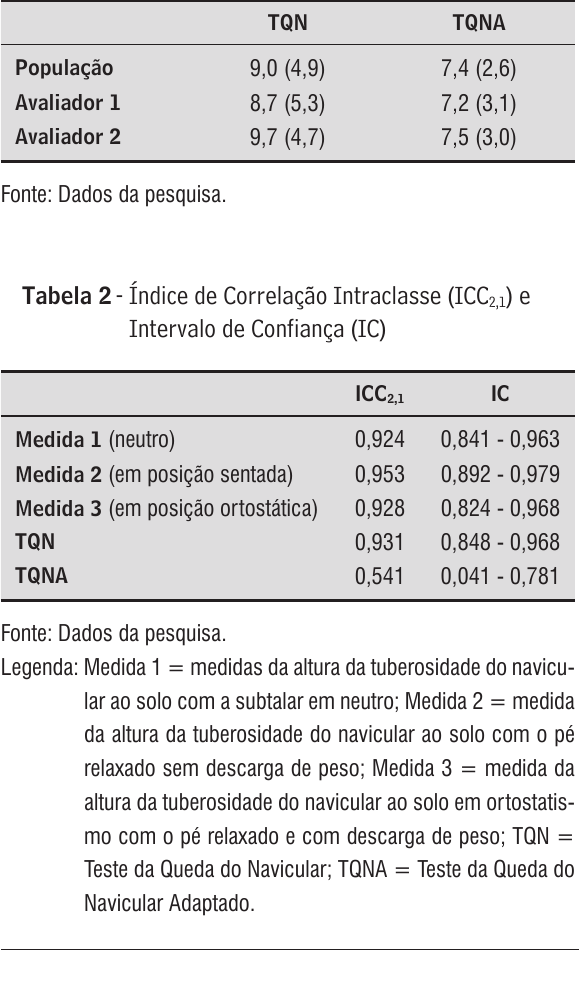
Tabela 1 - Média e desvio padrão dos dados referentes ao